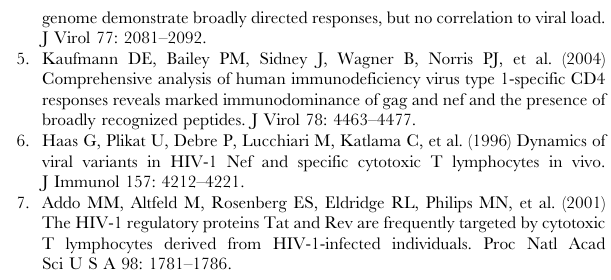
(TIF) Figure S2 IFN- c production in the high viremic subject. CD8 expression level versus the magnitude of IFN- c production using PBMC for clade-B consensus and autologous HIV-1 Nef sequences, as a percentage of total CD8 + T-cells. The negative control = non-stimulated, Positive control tube= (SEB) used Staph- ylococcus aureus Enterotoxin B superantigen as stimulant. (TIF) Figure S3 Gr-B/CD107a production in the high viremic subject. Intracellular expression of Granzyme B versus the level of immobilized CD107a on the cell surface of IFN- c + CD8 + T- cells following stimulation with clade-B consensus and autologous HIV-1 Nef peptides. Functional subpopulation (%) in the IFN- c + CD8 + T-cell population is also shown. (TIF) Table S1 A summary of the viral load and T-cell counts in different time points for the two study subjects. (XLSX) Table S2 Predictions of proteasomal processing, TAP transport and peptide binding to HLA class I molecules.